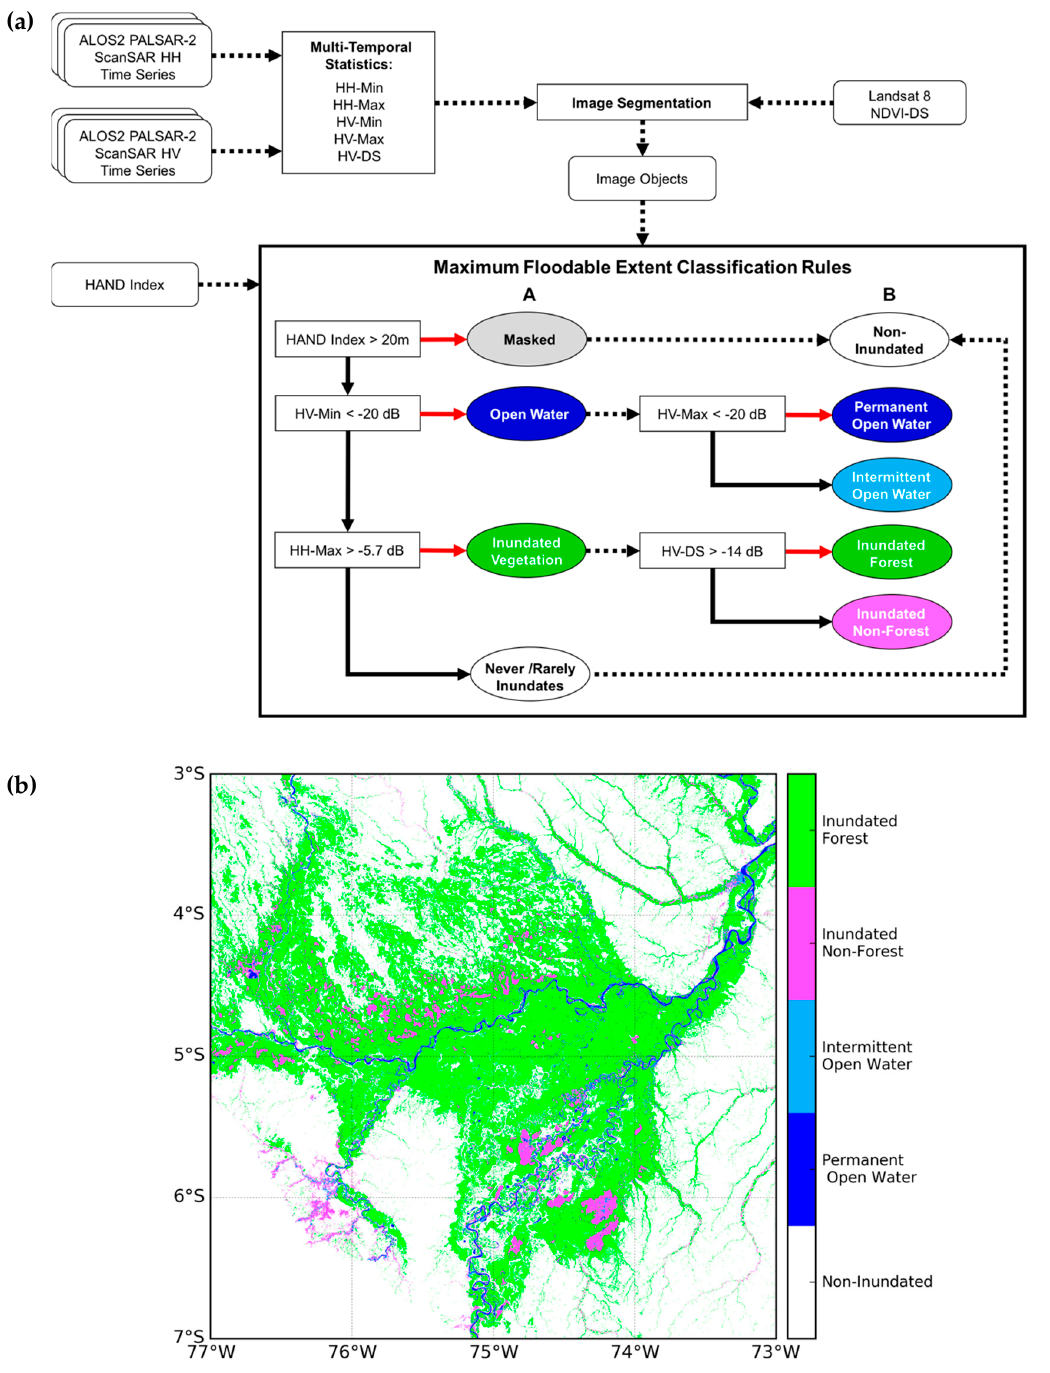
Figure 8. ( a ) Step 1, object-based classification algorithm for maximum flooded extent. Boxes with rounded edges indicate inputs; boxes with sharp corners indicate a process/decision; ovals indicate assigned classes. In the decision tree, bold red arrows correspond with “True” and bold black arrows with “False”. ( b ) Maximum flooded extent classification map.